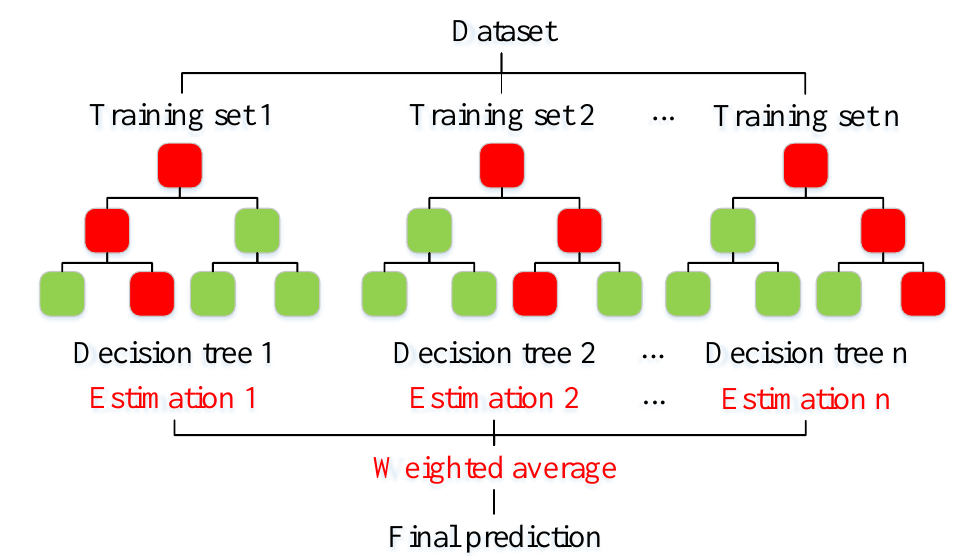
Figure 3. The architecture of random forest.